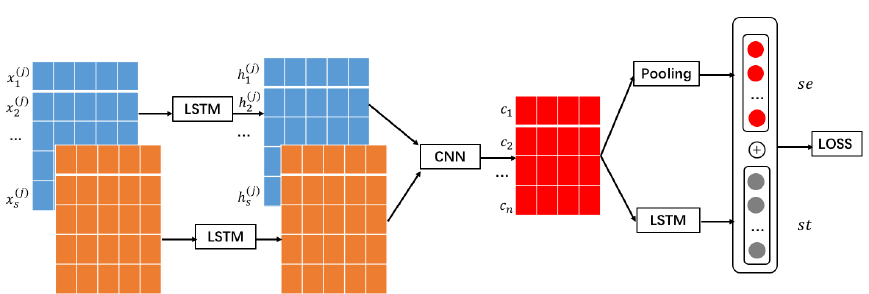
Figure 3. Dialog system